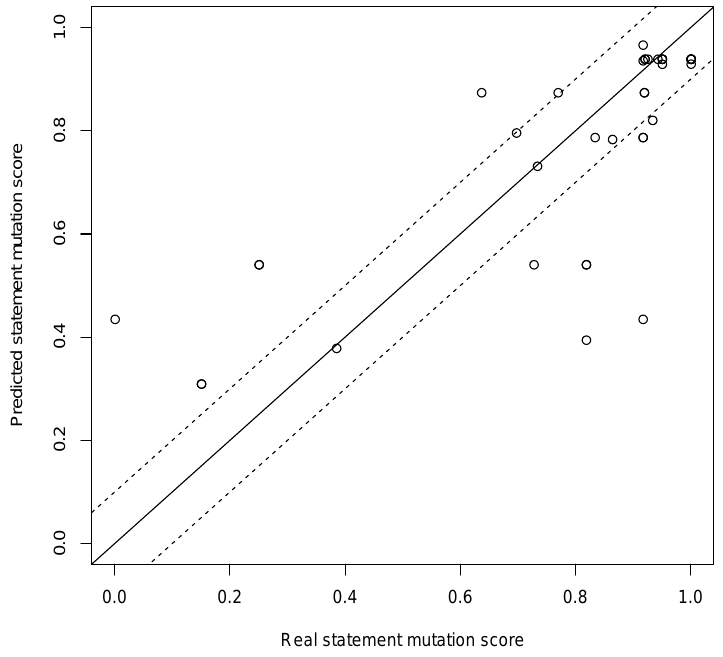
Figure 11. Comparing the real statement mutation scores and the predicted statement mutation scores in tcas.c by the artificial neural network.